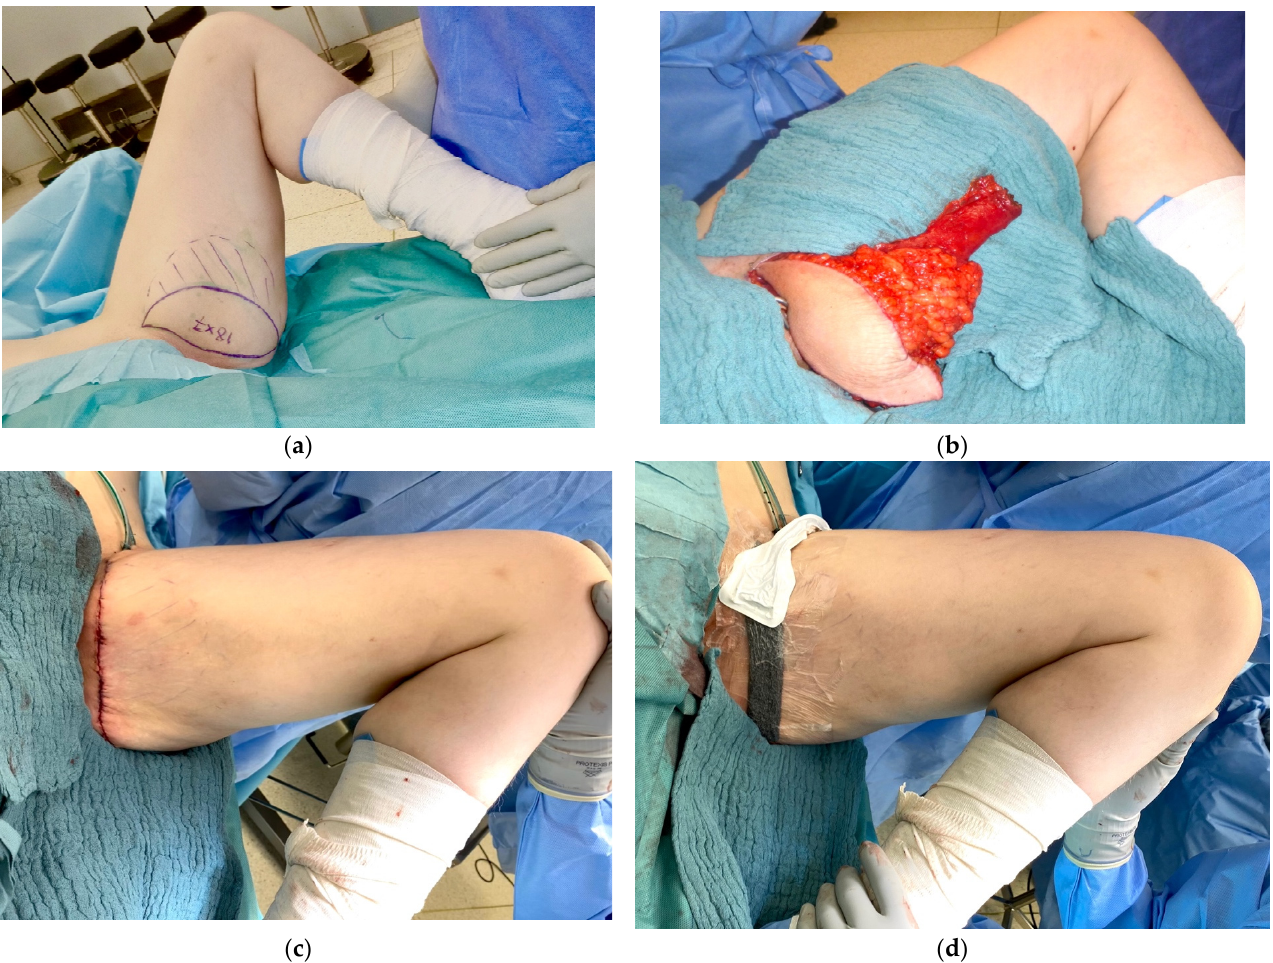
Figure 1. Intraoperative view of a normal-weight female patient (42 years, BMI 23.8 kg/m 2 ) under- going TMG flap harvest from the left thigh for free flap reconstruction of the right breast following successful breast cancer therapy. The patient suffered from invasive ductal carcinoma. In a previous surgery, nipple-sparing mastectomy was performed and an expander was placed in the right breast. ( a ) Patient in the supine position. Left leg in frog position with preoperative markings of the TMG flap outlining the skin island in average dimension (7 × 18 cm) and the subcutaneous fat extension to boost up flap volume. The skin island is limited to the medial aspect by the femoral neurovascular bundle and to the inferior part by a pinch grip. ( b ) TMG flap including the proximal skin island, the beveled fat extension, and part of the gracilis muscle. ( c ) Multi-layer closure of the donor site wound on the medial thighsimilar to a horizontal thigh lift. ( d ) CINPT on the closed suture line on the medial thigh donor site. The closed incision was covered with fatty gauze and customized black polyurethane foam. The transparent adhesive film was placed on the foam and small part of the surrounding skin. The soft port was placed and continuous negative pressure was